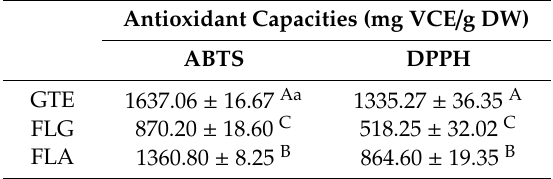
Table 3. Antioxidant capacities of green tea extract (GTE), the fraction rich in flavonol glycosides (FLG), and the fraction rich in flavonol aglycones